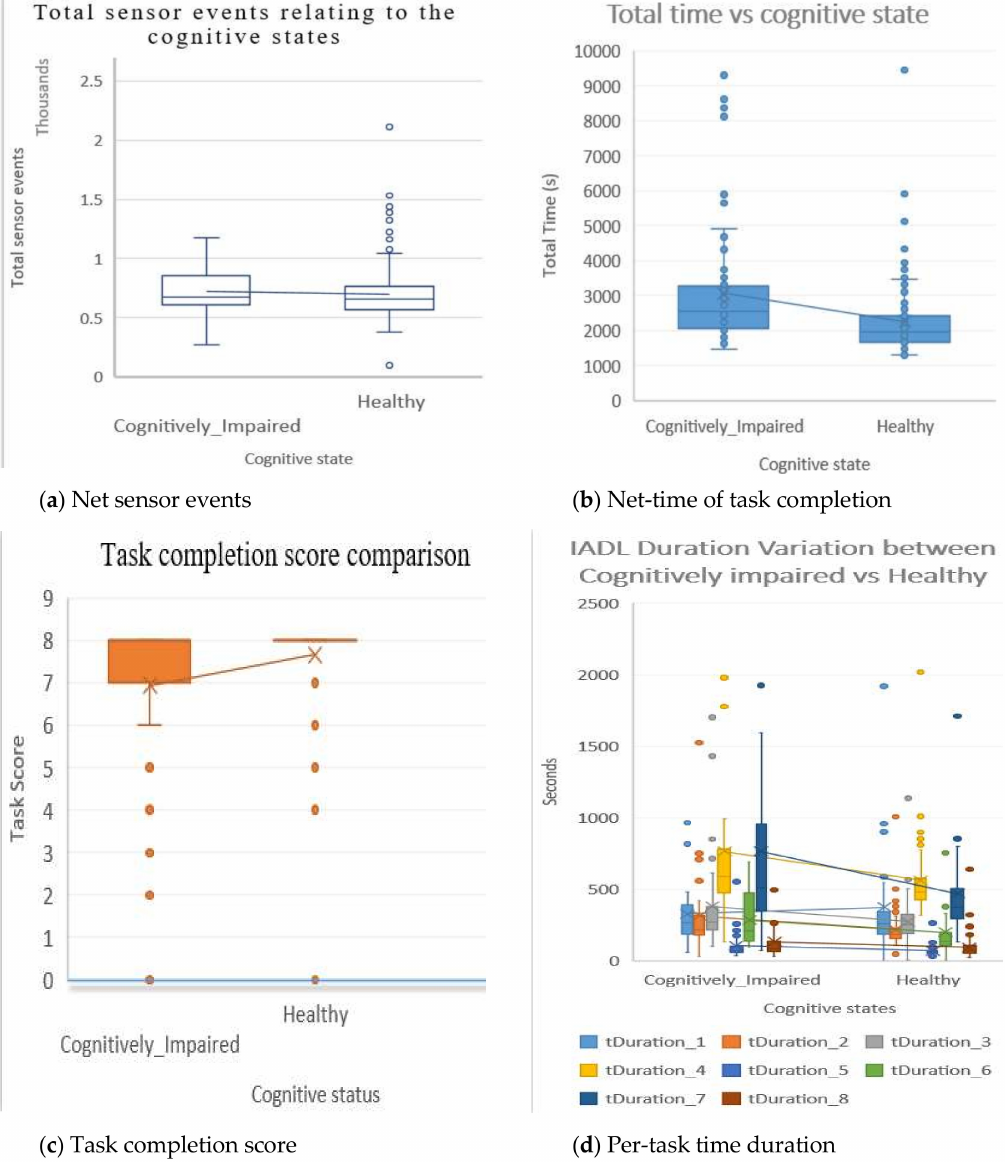
Figure 7. Patterns in the dataset on various parameters. ( a ) Net sensor events; ( b ) Net-time of task completion ( c ) Task completion score ( d ) Per-task time